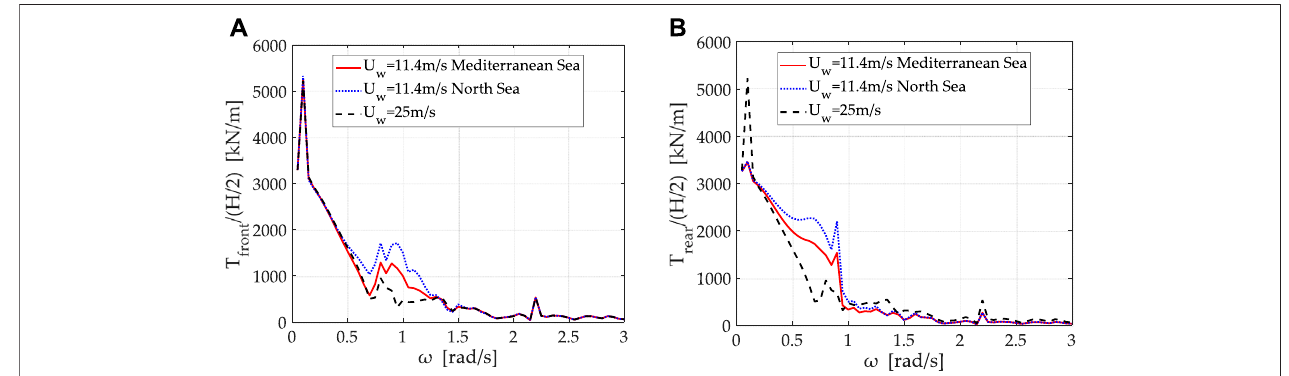
FIGURE 10 | Tension forces on the front and rear tendon of the hybrid structure in the Mediterranean- and North-Sea installation locations for operating and extreme environmental conditions: (A) T front / ( H 2 ) ; (B) T rear / ( H 2 ) . Here the wave heading angle equals to β (cid:1) 0 o.